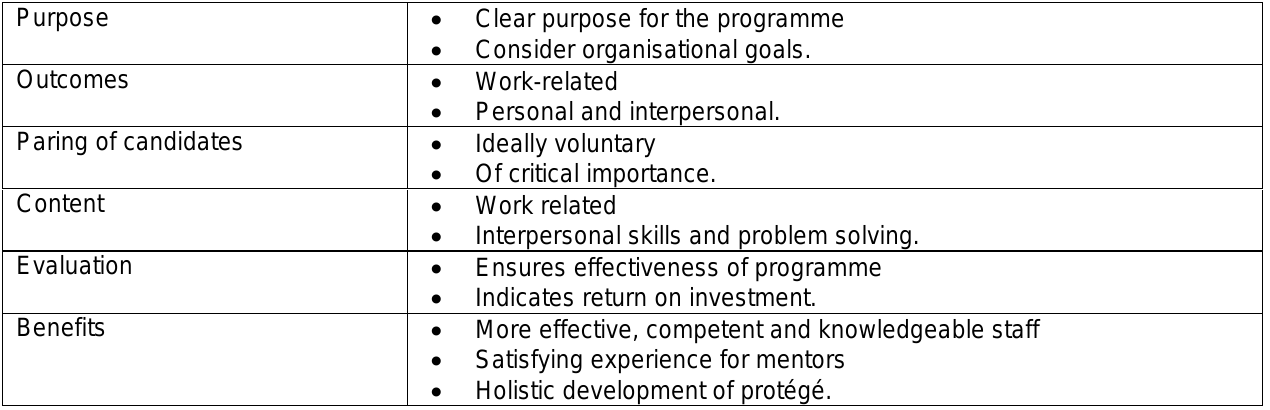
Table 1: Aspects related to a formal mentorship programme Purpose • Clear purpose for the programme Consider organisational